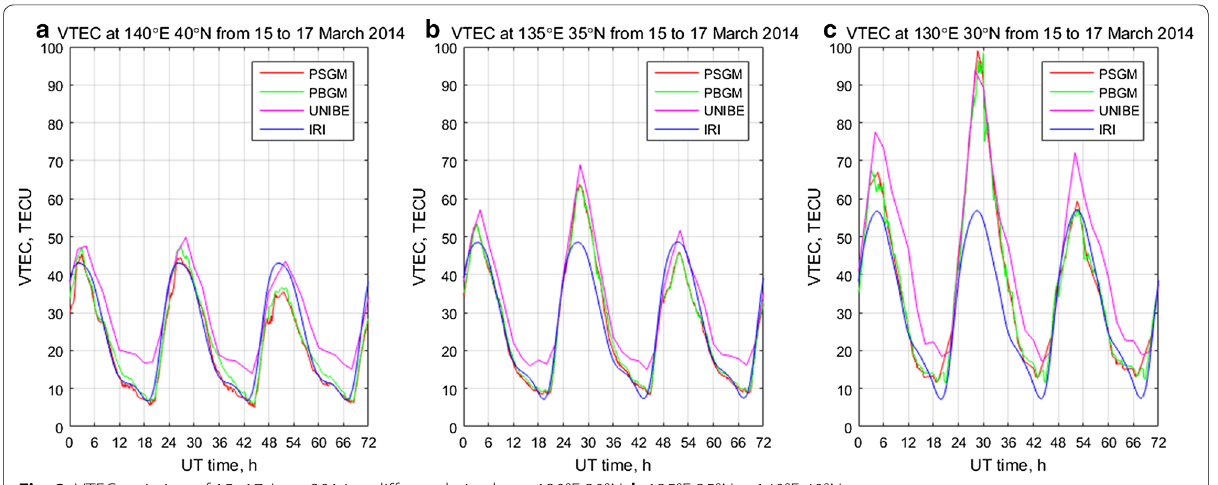
Fig. 2 VTEC variation of 15–17 June 2014 at different latitudes: a 130°E 30°N; b 135°E 35°N; c 140°E